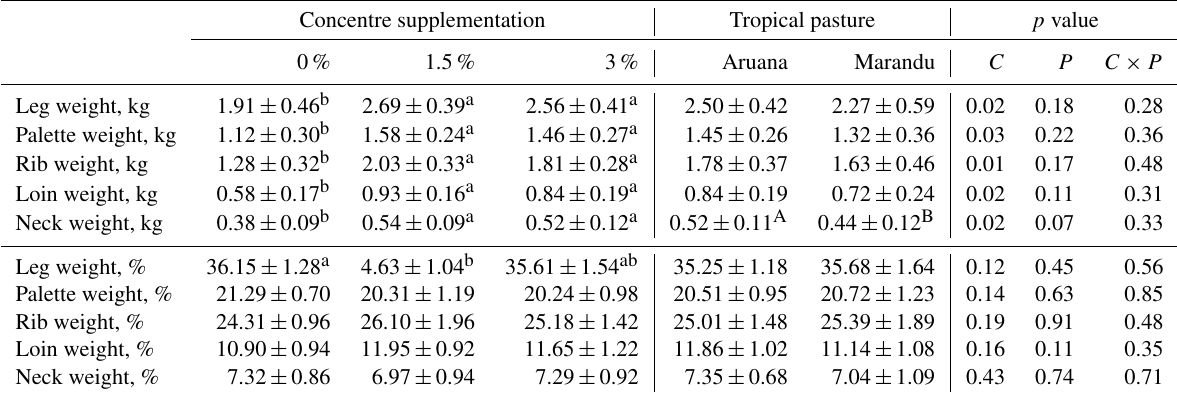
Table 4. Means, standard deviation, and effect of concentrate supplementation ( C ), tropical pasture type ( P ), and interaction ( C × P ) related to commercial cuts of the left half of the carcass of Suffolk